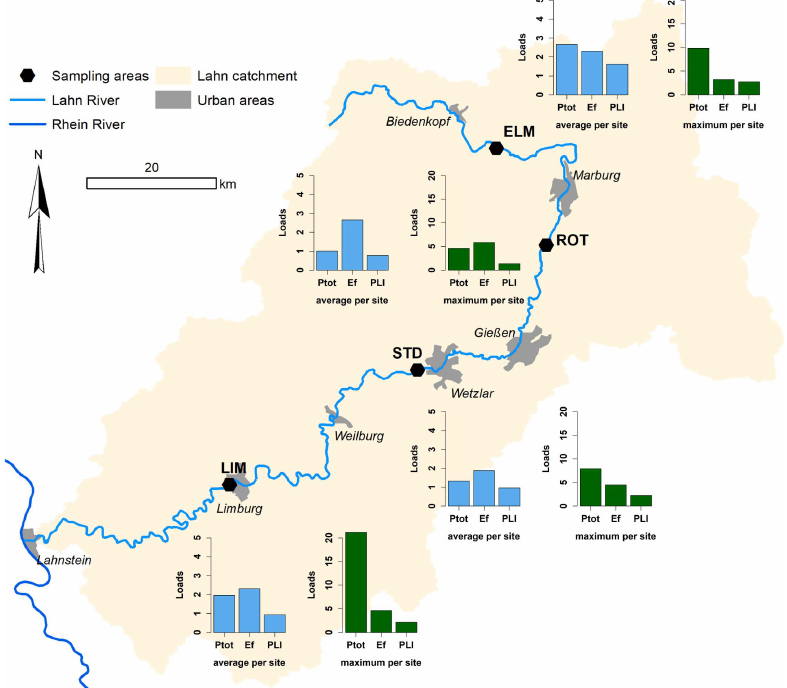
Figure 3. Overview of plastic and heavy metal loads in the Lahn catchment. Ptot: total plastic concentrations (p kg − 1 ), calculated as the mean value from all samples of a transect; Ef: enrichment factor; PLI: pollution load index (both calculated as the mean value from all metals analyzed in soil samples of a